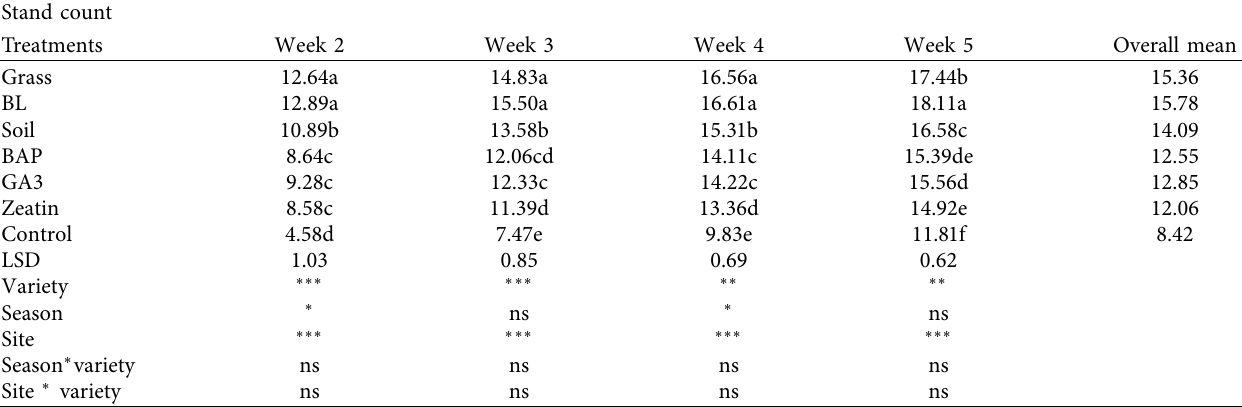
Table 6: Means effects of plant growth regulators and natural materials are on germinated plants (stand count) at different weeks after planting.